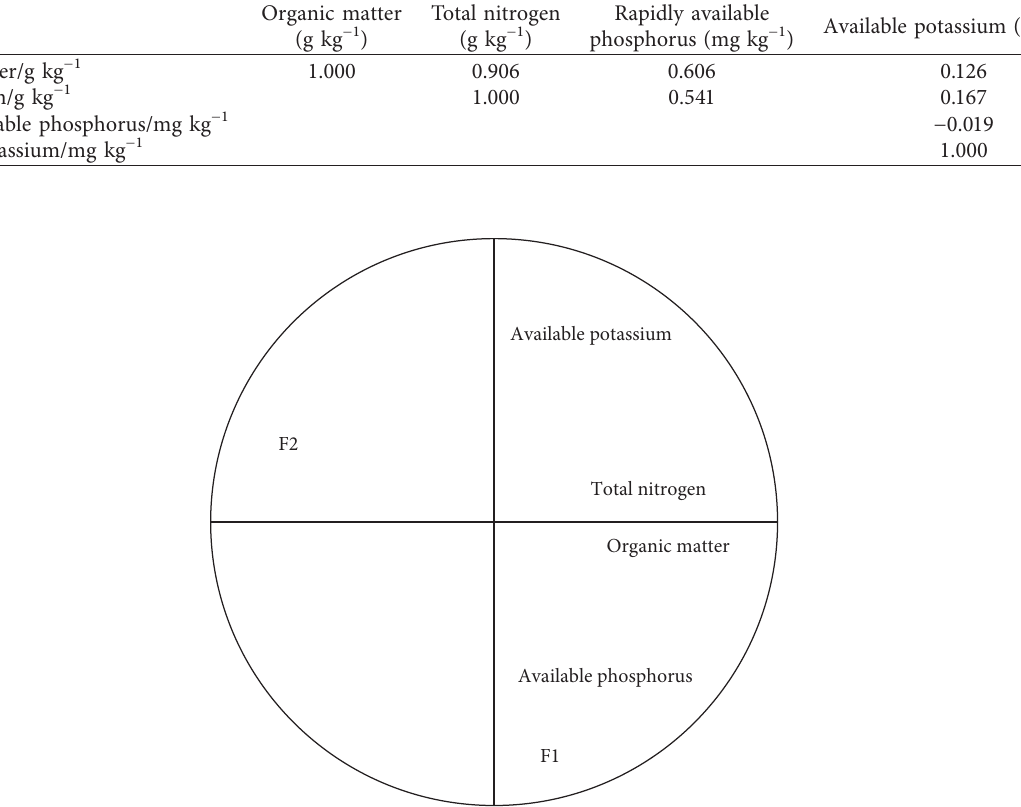
Figure 3: Analysis of the main chemical composition of the cultivated soil environment. Table 2: Analysis of fruit yield of sample trees under different planting techniques (%).